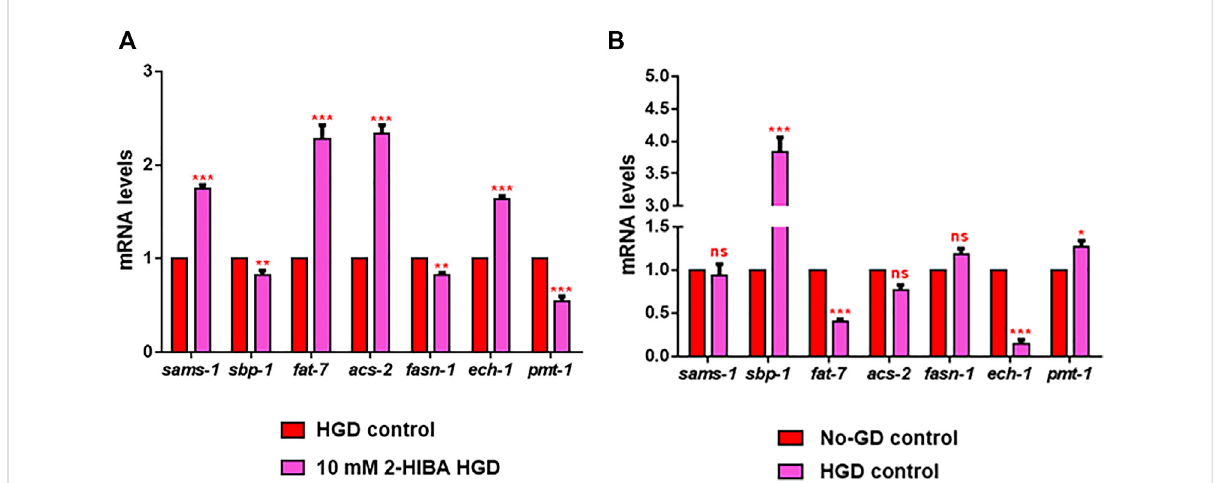
FIGURE 14 RT-qPCRanalysisoflipidmetabolismgenesinHGDworms. (A) Expressionof sams-1 , sbp-1 , fat-7 , acs-2,fasn-1,ech-1 and pmt-1 genesin2-HIBAHGD 1-dayadults,comparedtoHGDuntreatednematodes. (B) Expressionoflipidmetabolismgenesinuntreatedpopulations,grownwith(HGD)orwithout(No- GD) glucose. Experiments were performed in triplicate. Data are presented as mean ± SD (* p < 0.05, ** p < 0.01, *** p < 0.001, ns: not signi fi